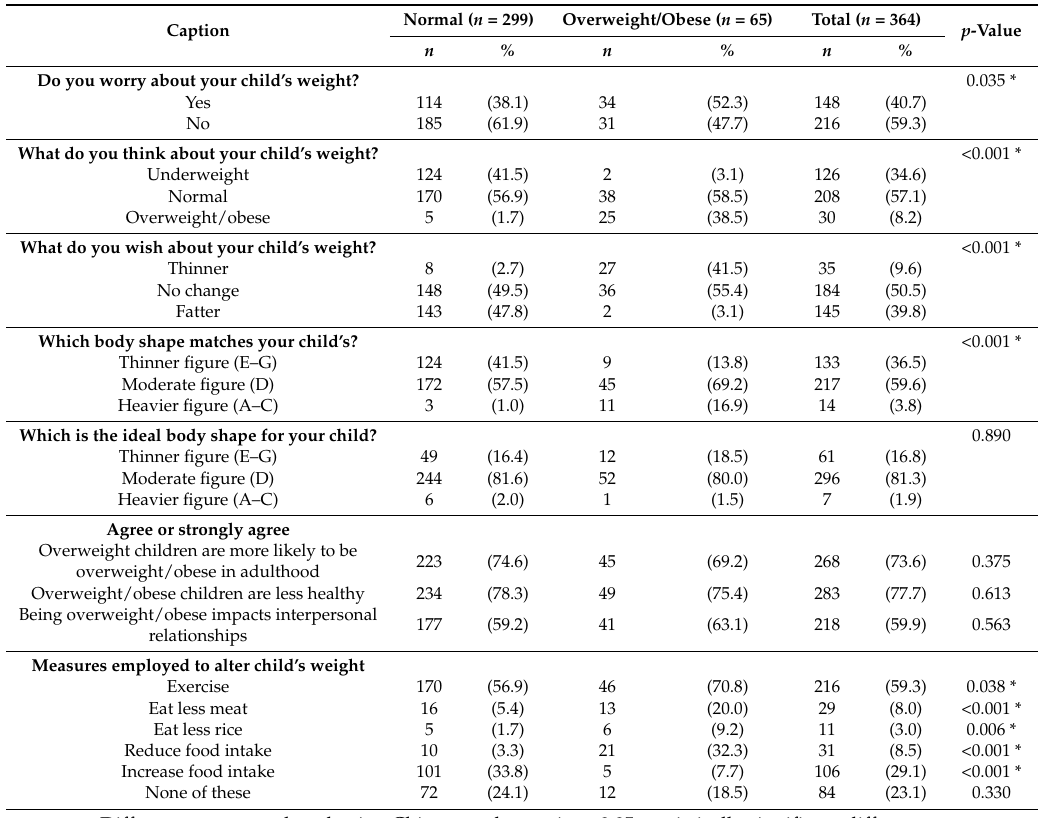
Table 3. Differences in caregiver attitudes, beliefs, and efforts pertaining to child weight between normal-weight and overweight/obese